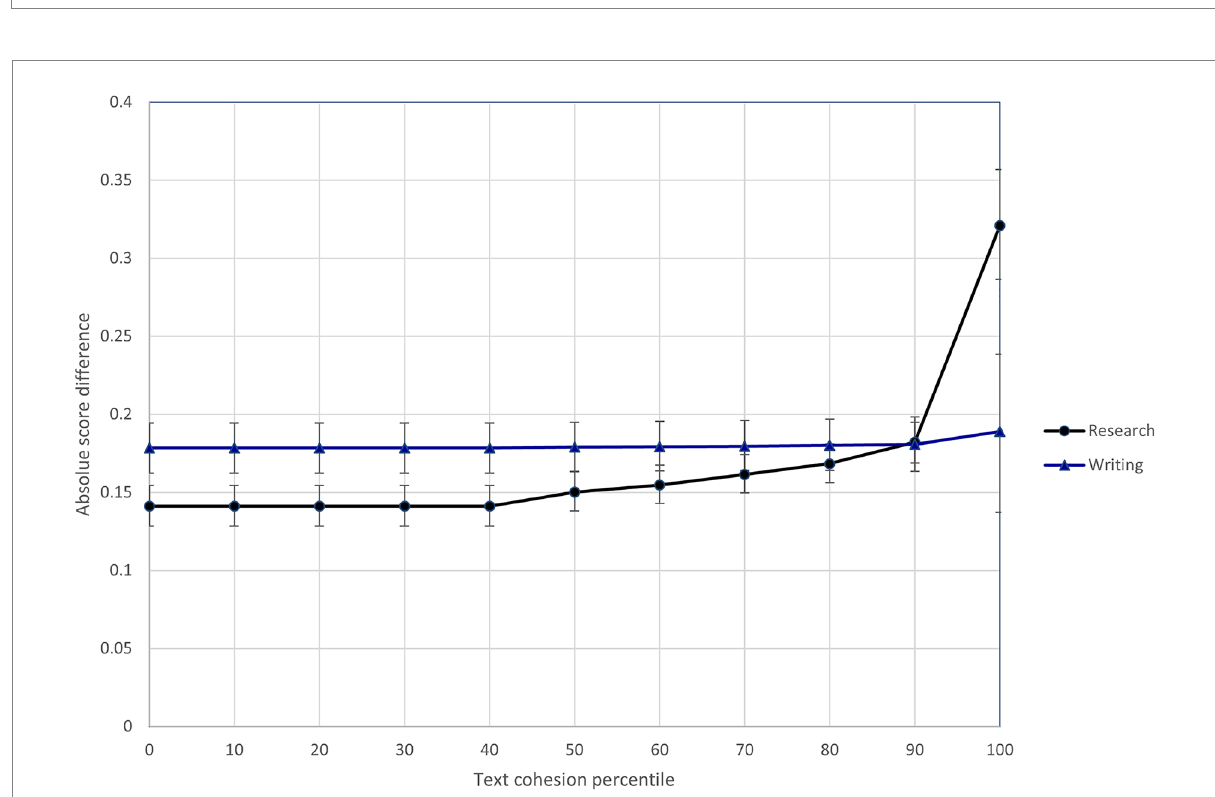
FIGURE 7 Differential influence of response text cohesion on difficulty of scoring research and writing content.